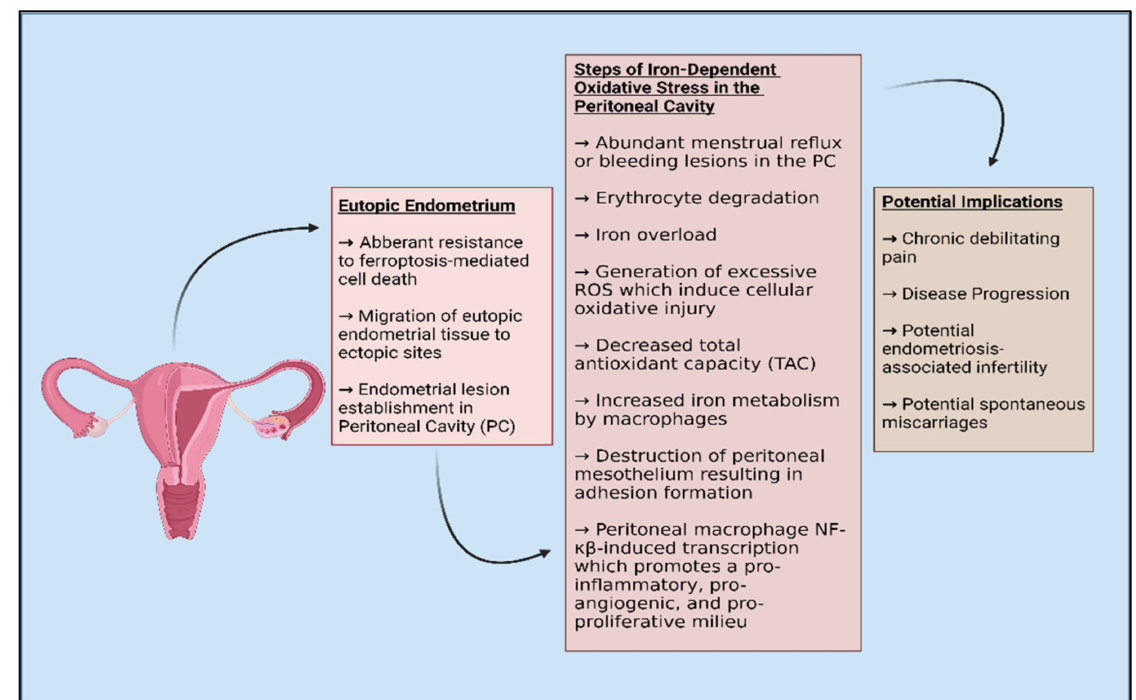
Figure 2. A simplified diagram of the etiology underlying iron-dependent oxidative stress character- istic of